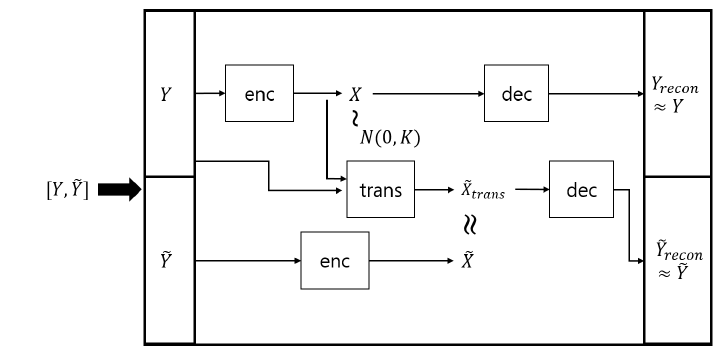
Figure 2. Schematic diagram of auto-encoded Gaussian process dynamical model.